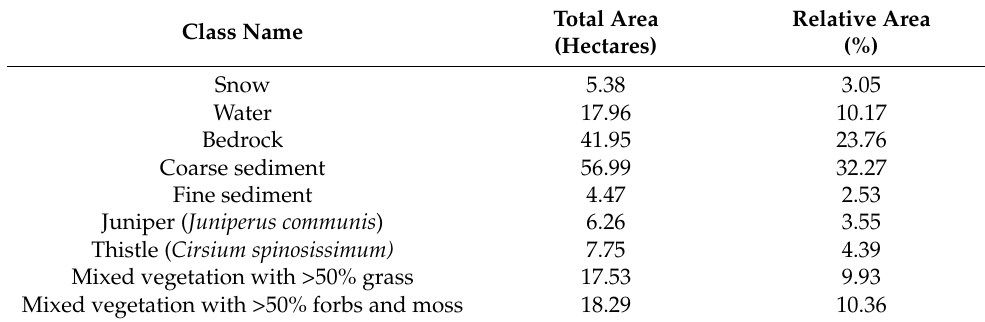
Table 5. Classification results based on the final RF model. Total and relative distribution of the defined classes in the research